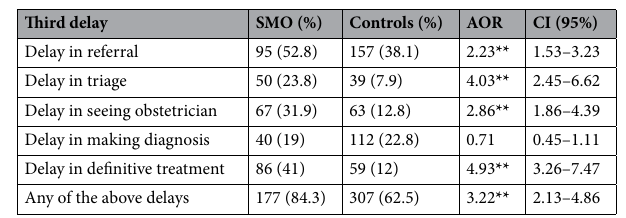
Table 4. Timeliness indicators as determinants of maternal outcome among women admitted to Keren Hospital. *Significant at p = 0.05.